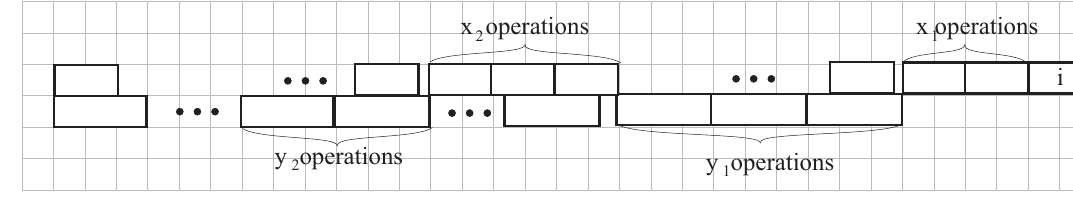
Figure 1. Illustration for the proof of Lemma 1.